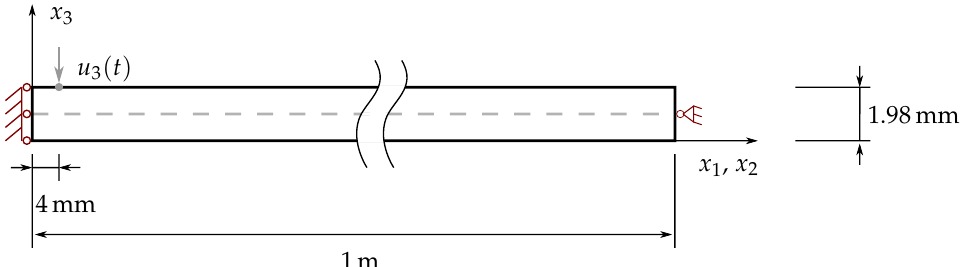
Figure 2. Numerical model for the computation of the dispersion diagrams including the boundary conditions.